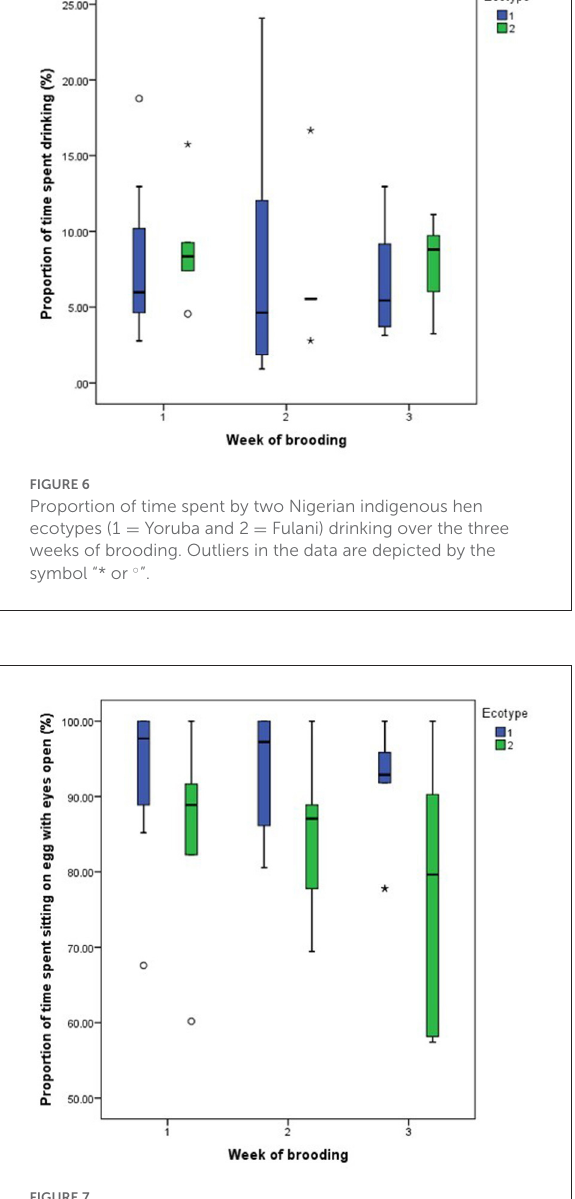
FIGURE7 Proportion of time spent by two Nigerian indigenous hen ecotypes (1 = Yoruba and 2 = Fulani) sitting on the egg with eyes open over the three weeks of brooding. Outliers in the data are depicted by the symbol “* or ◦ ”.